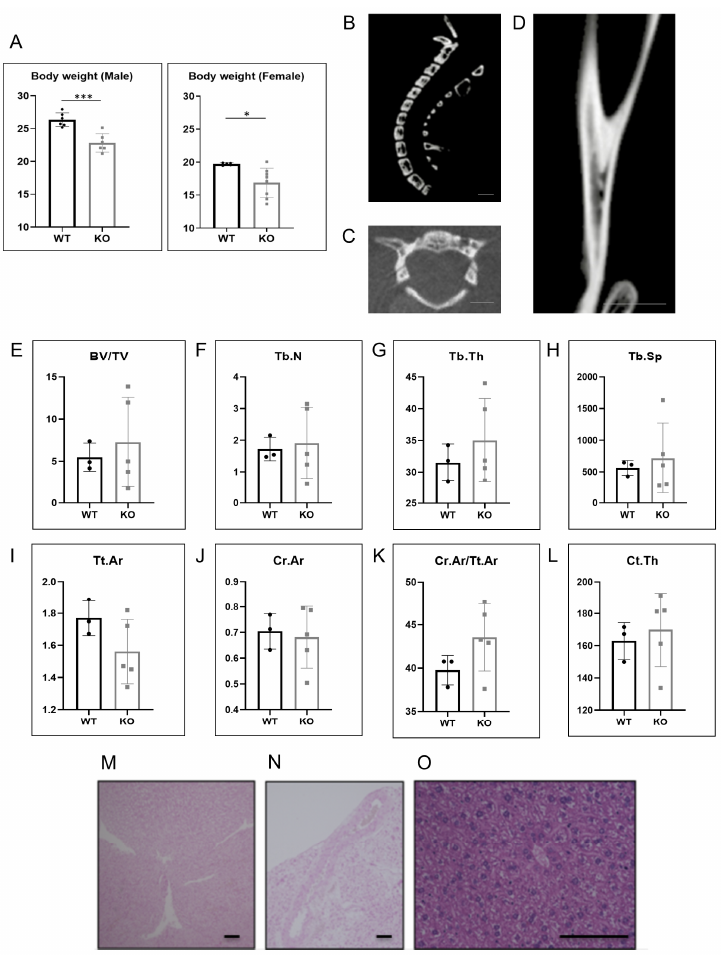
Figure 3 Figure 3. Body weight, micro CT, bone morphology, and histological evaluation. Eight-week-old Hao1-deleted CAG-Cre/Hao1 flox/flox (KO) mice were fed a high-phosphate diet for 2 weeks, and sacrificed at 10 weeks of age. ( A ) Comparison of body weights of male and female WT and KO mice at 10 weeks of age. Data represent mean values of indicated parameters ± S.D. (* p < 0.05; *** p < 0.001). ( B , C ) Micro CT analysis of sagittal ( B ) and axial ( C ) slices of spinal column. Scale bar = 2 mm. ( D ) Micro CT analysis of sagittal slice of tibia. Scale bar = 2 mm. ( E – L ) Bone morphology analysis of distal femoral metaphysis. ( M – O ) Von Kossa-stained images of kidney ( M ) and aorta ( N ) and of HE-stained liver ( O ). Scale bars = 100 µ